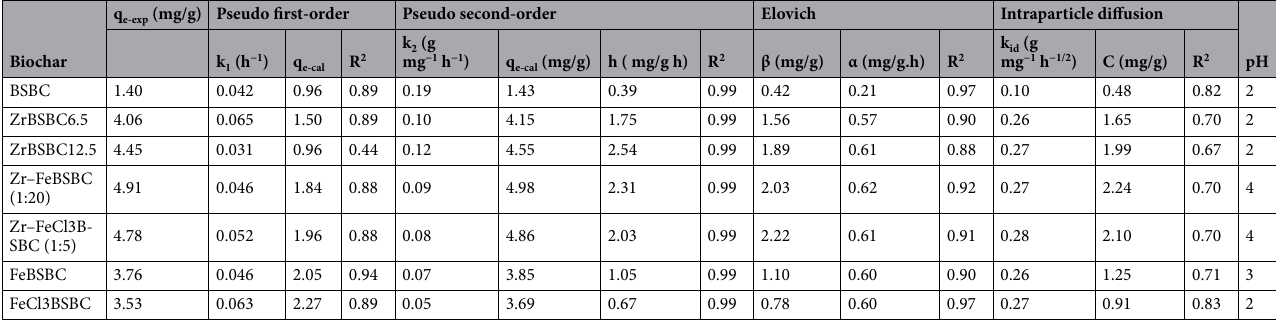
Table 1. Kinetic models and fitted parameters for Sb(V) sorption